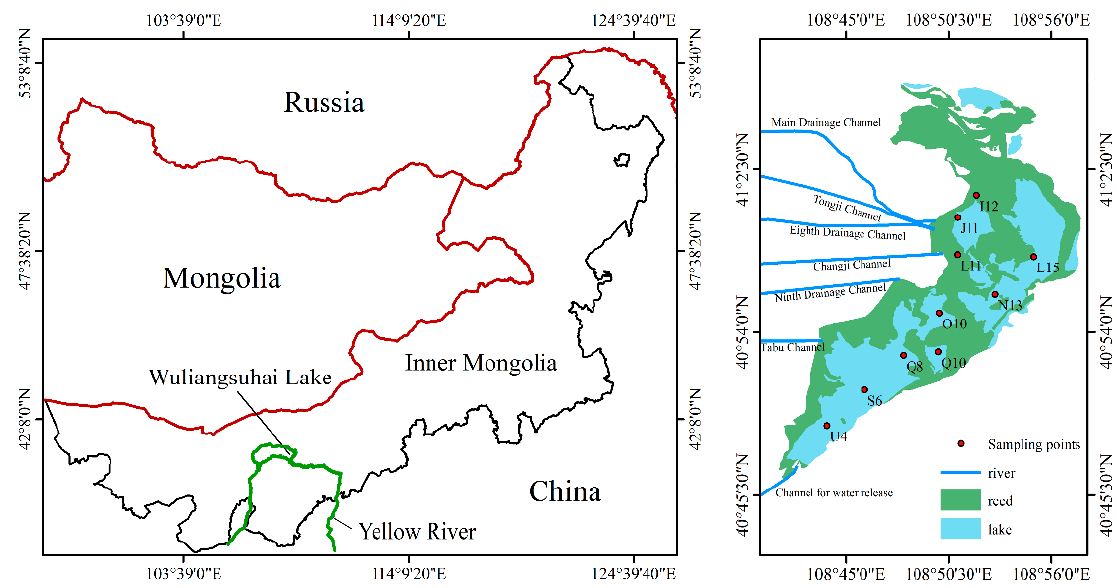
Figure 1. Geographic locations of Wuliangsuhai Lake and sampling points.